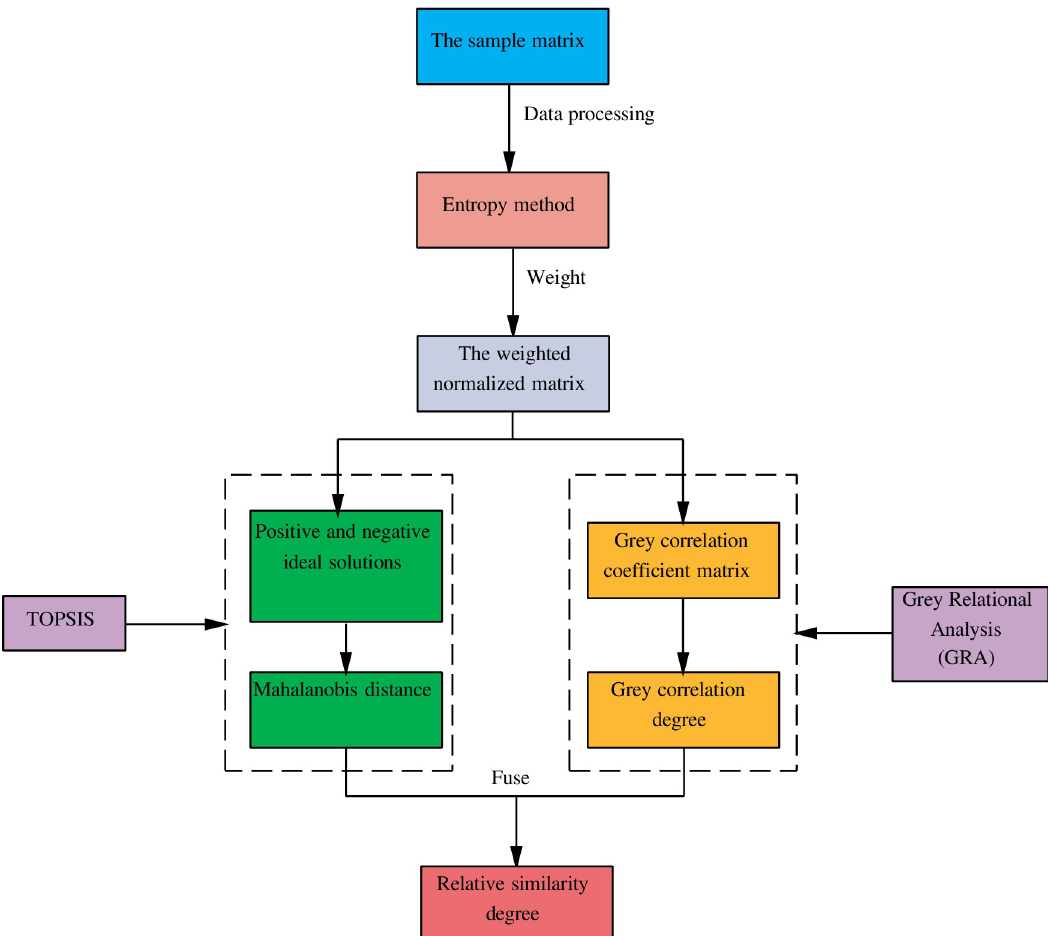
Fig 3. The mechanism of improved TOPSIS and grey relational analysis